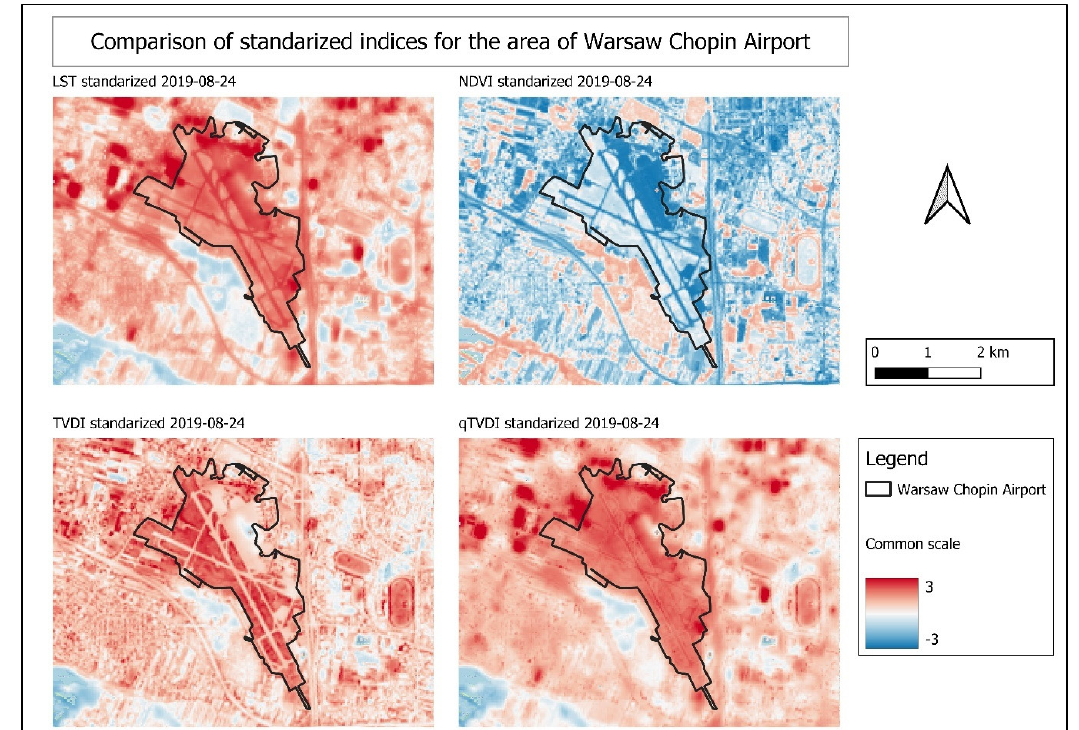
Figure 8. Distribution maps of standardized LST , NDVI , TVDI , and qTVDI on 24 August 2019.